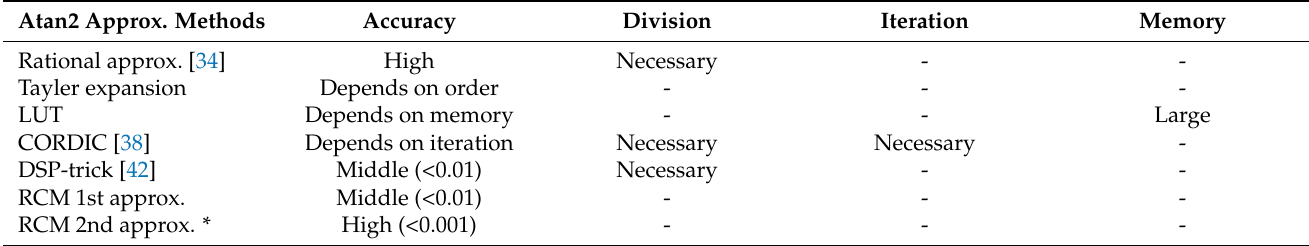
Table 6. Comparison with other methods.